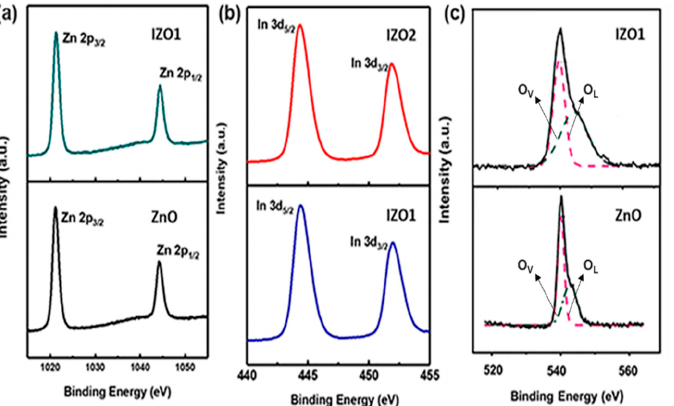
Figure 18. XPS spectra of ZnO and IZO films ( a ) XPS Zn 2p core level spectra of ZnO and IZO1. ( b ) XPS In 3d spectra of IZO1 and IZO2 . ( c ) XPS O1s spectra for a) ZnO and b) IZO2. Reproduced with permission from Ref. [93]; published by Elsevier, 2019.